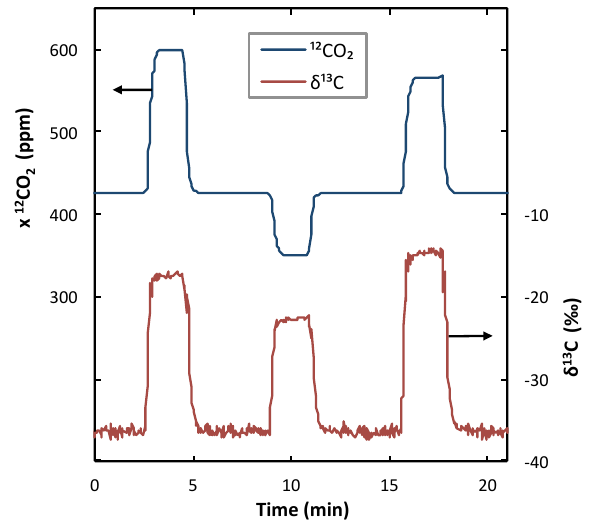
Figure 2. Example CRDS data feed for syringe samples. Reference air measurements (ca. 425ppm x 12 CO 2 and − 37‰ δ 13 C–CO 2